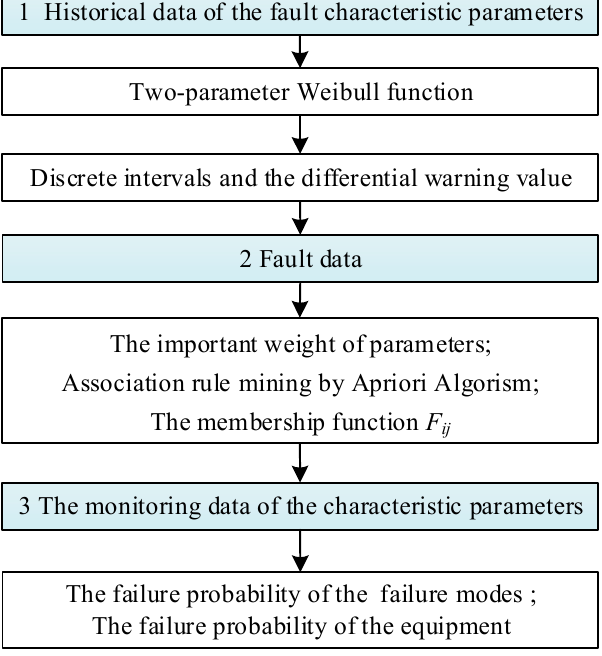
Figure 3. The flow of the failure probability calculation.